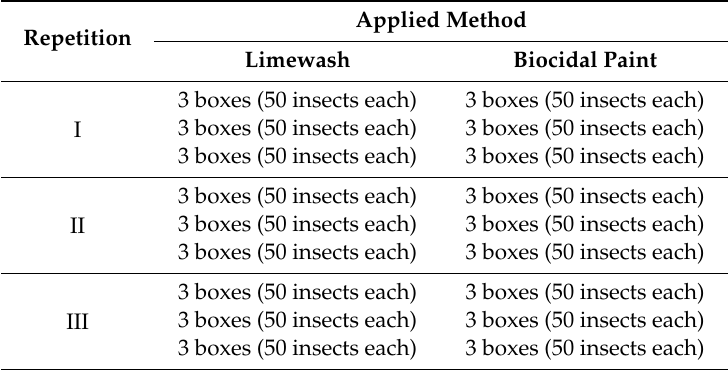
Table 1. Experimental scheme in laboratory